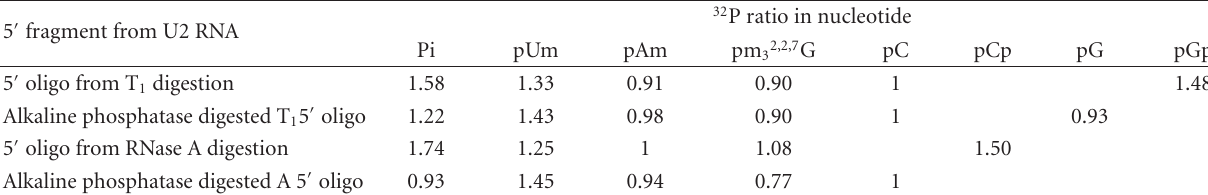
Table 11: The analysis of [ 32 P]-labeled U2 RNA 5 (cid:2) oligonucleotide [12]. The 5 (cid:2) ends obtained from uniformly [ 32 P]-labeled U2 RNA were digested with T1 RNase or RNase A and isolated by two-dimensional electrophoresis (cellulose acetate at pH 3.5 followed by DEAE paper electrophoresis). The 5 (cid:2) oligonucleotides were digested with snake venom phosphodiesterase before and after removal of 3 (cid:2) phosphate with bacterial alkaline phosphatase. The products were separated as in Figure 27. The radioactivity ratios are listed. 32 P ratio in 5 (cid:2) fragment from U2 RNA